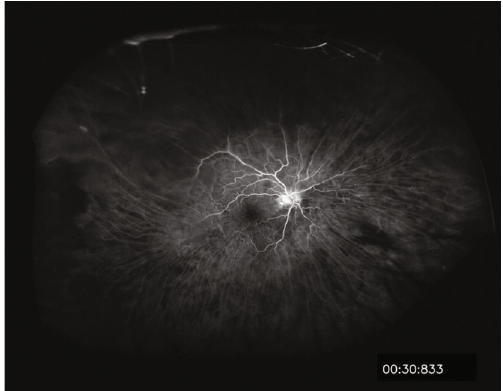
Figure 2: Fluorescein angiography at 30 seconds shows peripheral nonperfusion and prolonged fi lling